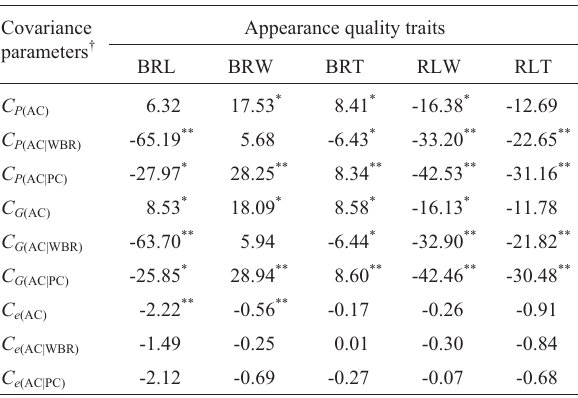
Table 1 - Estimated phenotypic and genotypic covariance components from the unconditional and conditional analysis between amylose content (AC) and the appearance quality traits (AQT), including brown rice length (BRL), brown rice width (BRW), brown rice width (BRT), ratio of brown rice length to width (RLW) and ratio of brown rice length to thickness